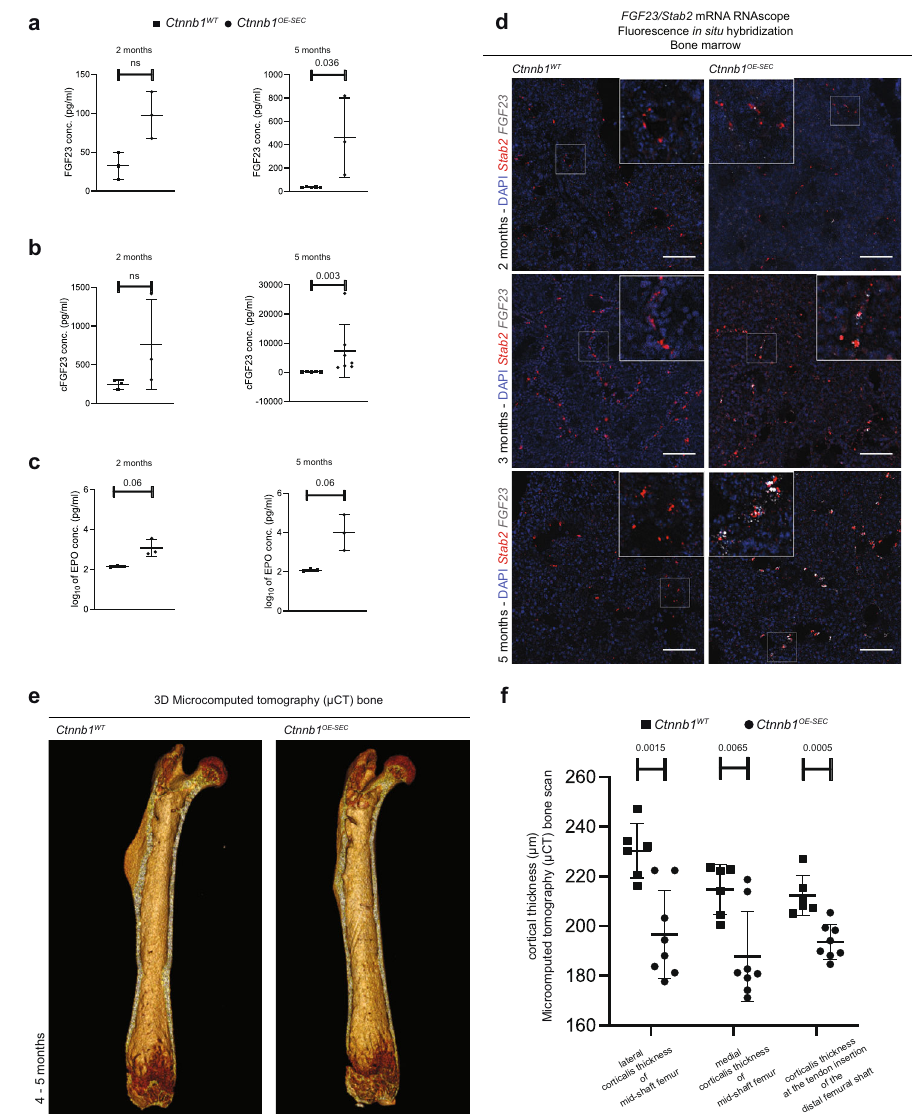
Fig. 5 Ctnnb1 OE-SEC mice show de novo expression of FGF23 in BM-SECs and serum. a Serum FGF23 (2-month-old mice, n = 3; 5-month-old mice, n ≥ 3), b cFGF23 (2-month-old mice, n = 3; 5-month-old mice, n ≥ 5), and c EPO levels (2- and 5-month-old mice, n = 3) of Ctnnb1 WT and Ctnnb1 OE-SEC mice measured by ELISA. The dots in the graphs represent individual female mice. d mRNA RNAScope ® FISH assay with DAPI, FGF23 (white) and Stab2 (red) of Ctnnb1 WT and Ctnnb1 OE-SEC bone marrow (2-, 3-, and 5-month-old male mice, n ≥ 3). Scale bars: 50 μ m. e , f Micro-computed tomography ( μ CT) bone scan of femurs (right and left limb) of 4- and 5-month-old female Ctnnb1 WT ( n = 6 from three mice) and Ctnnb1 OE-SEC ( n = 8 from four mice). e Exemplary view of the inside from a 3D reconstructed μ CT scan of Ctnnb1 WT and Ctnnb1 OE-SEC femurs. f μ CT quanti fi cation of corticalis thickness ( μ m) at selected femoral regions. The dots in the graphs represent measurements of the lower extremities (right and left limb) of individual mice. Mean± s.e.m. is shown for each group of mice in all graphs. Statistical signi fi cance was determined using Student ’ s t -test or Mann – Whitney U test (two-sided). ns, not signi fi cant. Source data, precise values of n and employed statistical tests for a , b , c , f are provided as a Source Data fi